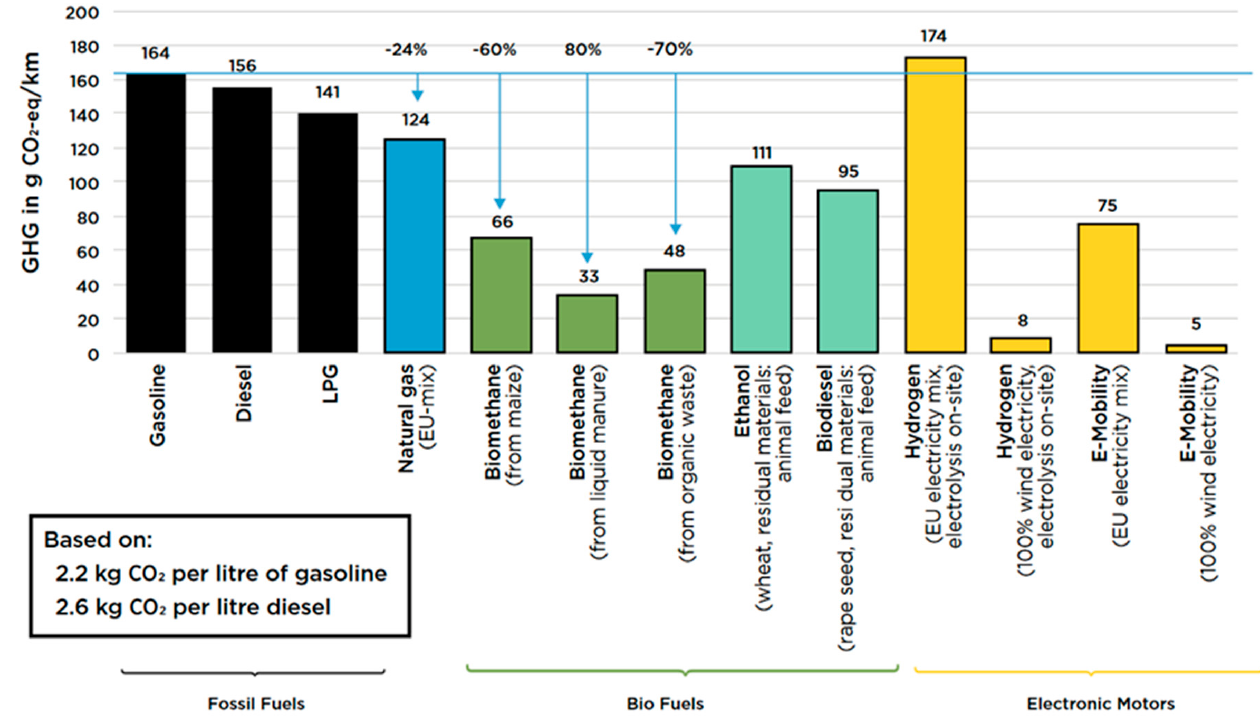
Figure 1. Comparison of GHG emissions from passenger cars fueled with different fuels [43]. The reduction of greenhouse gas emissions by biomethane fuel throughout the life cycle compared to the use of conventional fuels is due not only to the combustion process in the engine but also to the technology of its production [44,45]. The type of substrate used for methane fermentation has the greatest impact on the reduction of GHG emission in the whole life cycle. For biomethane produced from arable crops such as maize, greenhouse gas specific distance emission, expressed as CO 2 -eq, is 66 g/km, of which more than 50% is attributed to cultivation (nitrogen fertilization) and harvesting of raw materials (fuel combustion), and 28% to the process of purification and upgrading of biogas to natural gas quality. Greenhouse gas emission, thanks to the use of biomethane produced from edible raw materials, can therefore be reduced by approximately 60% compared to gasoline [43]. The use of manure (waste material) as input for the production of biogas reduces green- house gas emission by approximately 80% compared to gasoline, and the use of biomethane from municipal waste reduces greenhouse gas emission by approximately 73% compared to fossil fuels. For biomethane from municipal waste, the standard assumption is that the emission factor expressed in CO 2 -eq is 83.8 g/MJ, according to the Renewable Energy Directive (RED) [46]. This means a reduction in greenhouse gas emission per kilometer driven by around 70% compared to a petrol-powered passenger car. If, on the other hand, during the production of biomethane, the places of uncontrolled methane emission,